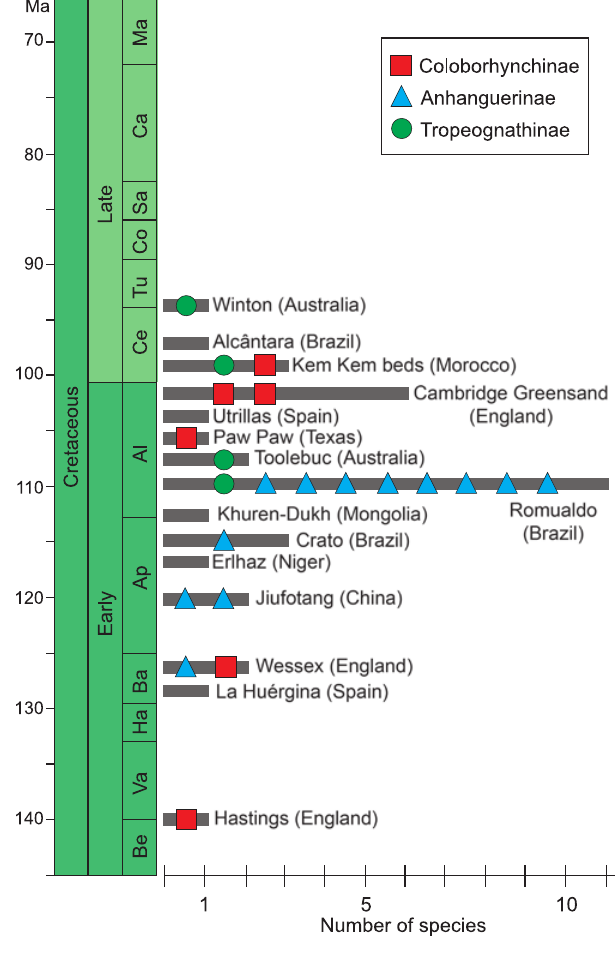
Fig. 14. Histogram showing the distribution of the species and specimens attributed to Anhnagueridae during the Cretaceous. Each bar of the his­ togram represents the number of diverse species found in each labelled site, whilst the geometric figures identified the species within the three an­ hangerid clades: Coloborhynchinae, Anhanguerinae, and Tropeognathinae. Drawing by BH. Abbreviations: Al, Albian; Ap, Aptian; Ba, Barrenian Be, Berriasian; Ca, Campanian; Ce, Cenomanian; Co, Coniacian; Ha, Hauteri­ vian; Ma, Maastrichtian; Sa, Santonian; Tu, Turonian; Va,